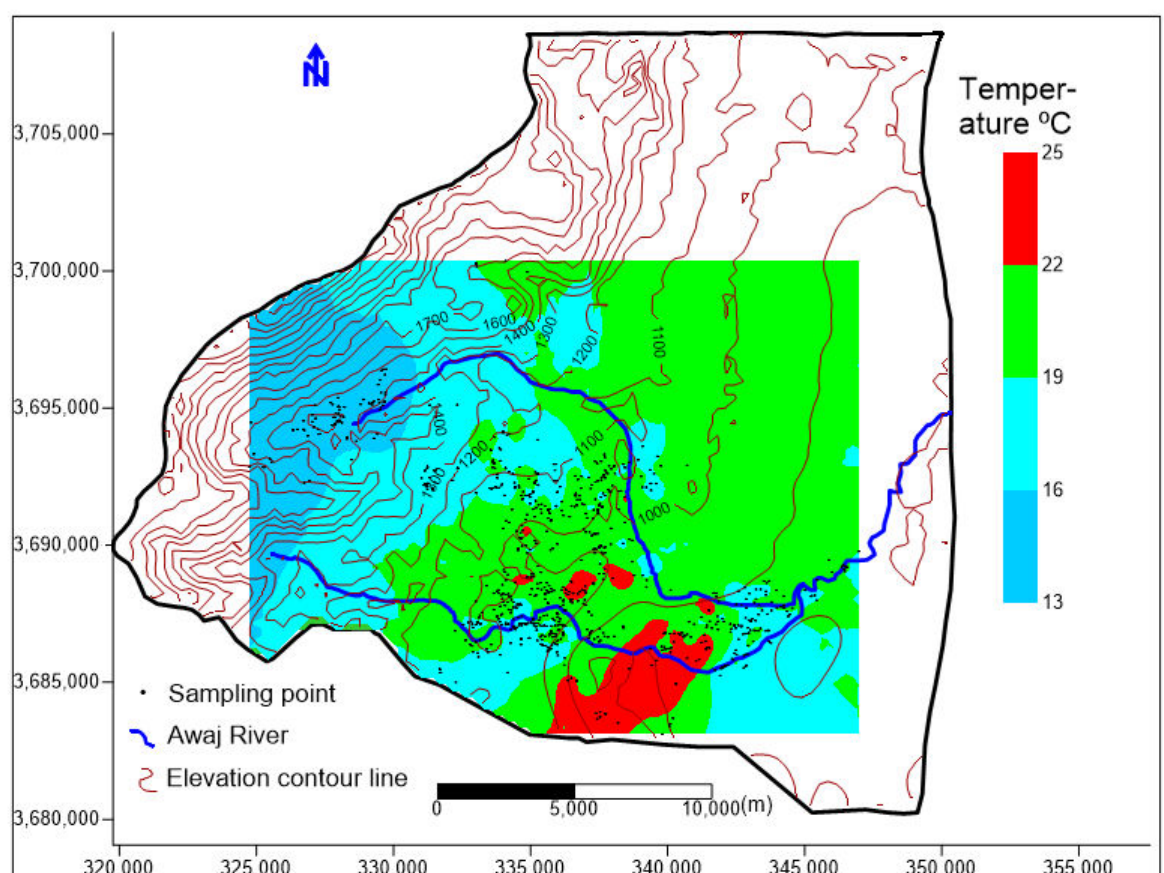
Figure 12. Spatial distribution of groundwater temperature (T, ◦ C) in the study area based on available data of field survey conducted from July to August